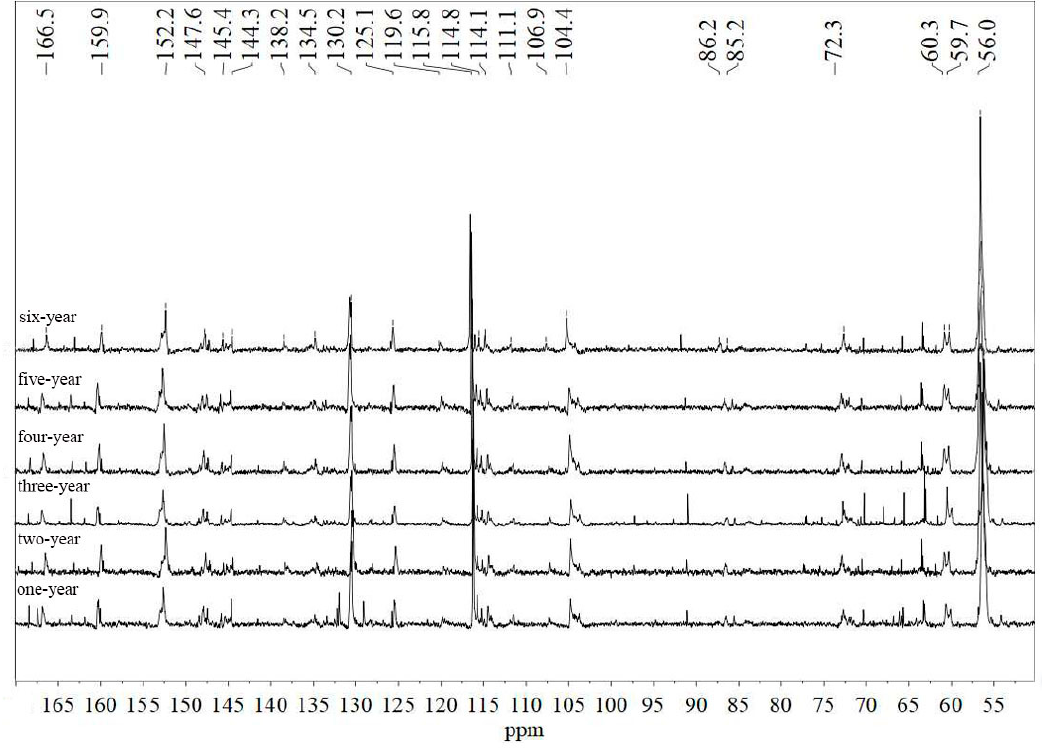
Figure 3. 13 C NMR spectra of 1–6 year-old bamboo lignins.